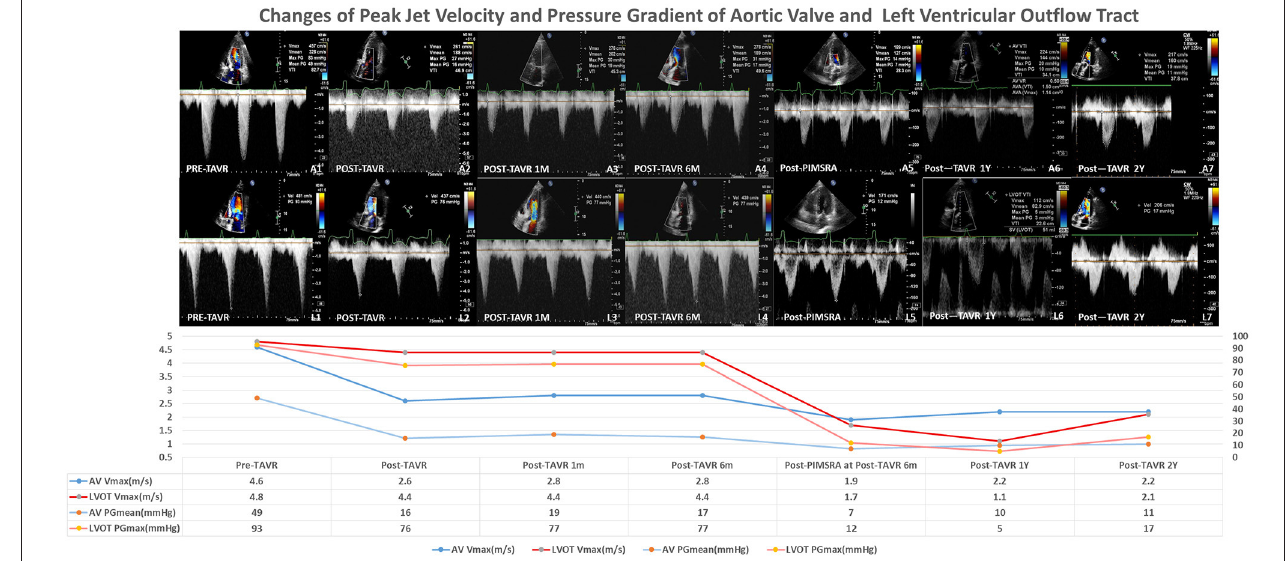
FIGURE 1 | Changes of peak jet velocity and pressure gradient of aortic valve and left ventricular outflow track.